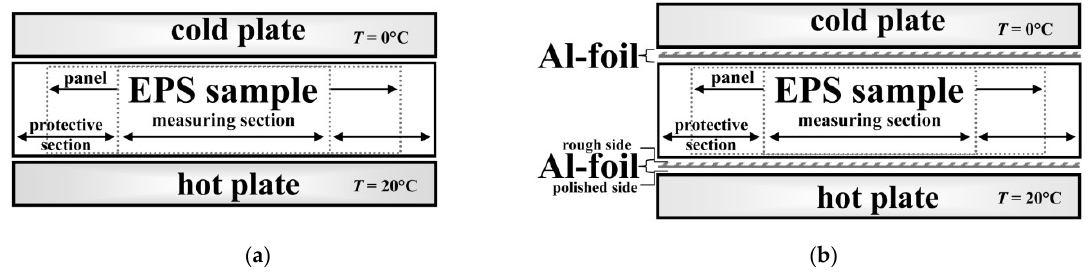
Figure 2. Schematic design of the measurement system in: ( a ) standard and ( b ) nonstandard method. Details of the expanded uncertainty calculations regarding the thermal conductivity measurements are explained in Supplementary Material part 2. The average expanded uncertainty < U ( λ ) > values of λ ( d ) were calculated from all experimental uncertainties U ( λ ), within the whole thickness range under study, individually for each type of EPS product. The results are given in Section